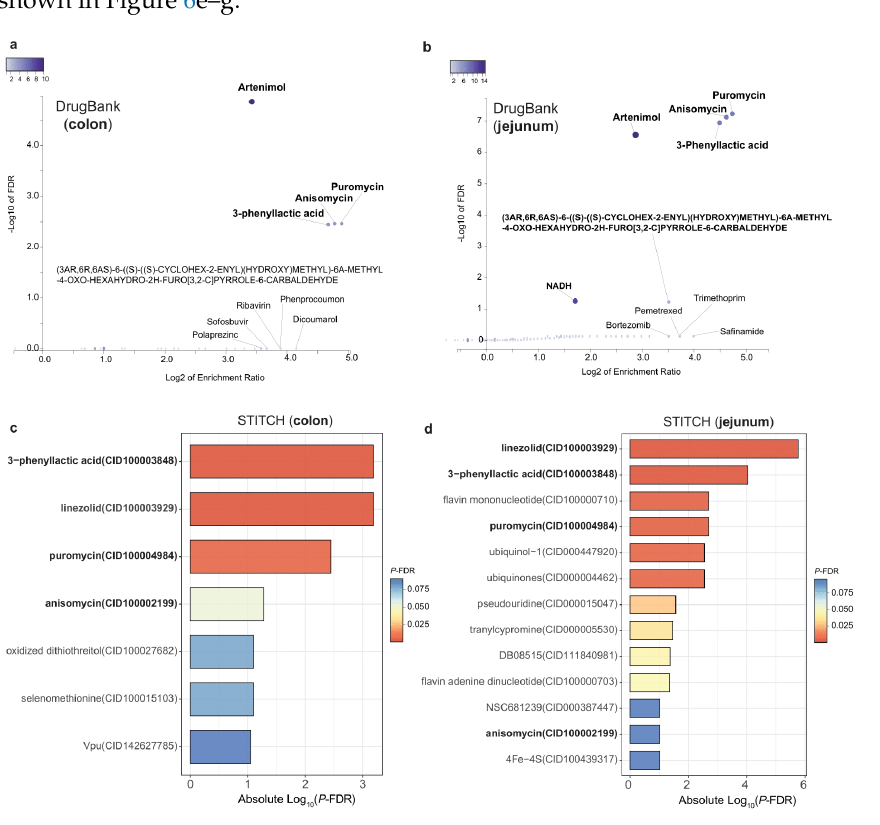
Figure 6 . Gene-drug enrichment analysis of significant genes associated with the expression of DPP9 . ( a ) Volcano plot of the gene-drug enrichment results from significant genes associated with DPP9 in the colon and ( b ) in the jejunum using the DrugBank database. Significant drugs in bold (Spearman ’ s p -value < 0.05, FDR < 0.1). ( c ) Barplot of gene-drug enrichment results from significant genes associated with DPP9 in the colon and ( d ) in the jejunum using the STITCH database. Significant drugs in bold (Spearman ’ s p -value < 0.05, FDR < 0.1). ( e – g ) Protein-drug interaction networks of puromycin, 3-phenyllactic acid and linezolid, respectively. 4. Discussion and Conclusions DPP9 is a recently identified member of the dipeptidyl peptidase IV enzyme family. Despite being highly prevalent in several tissues, little is known about its biological role compared to the most well-charaterized member of this family, DPP4. However, two